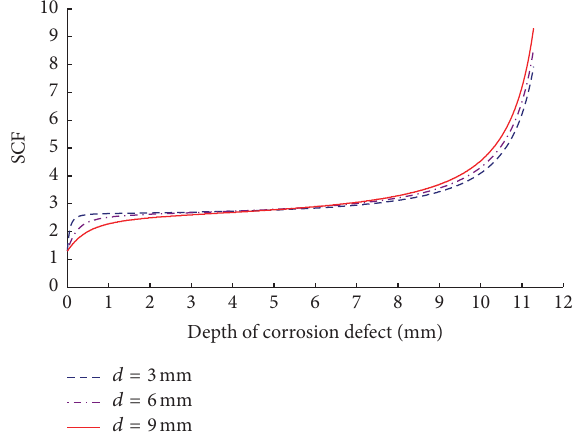
Figure 6: SCF change with the depth of corrosion